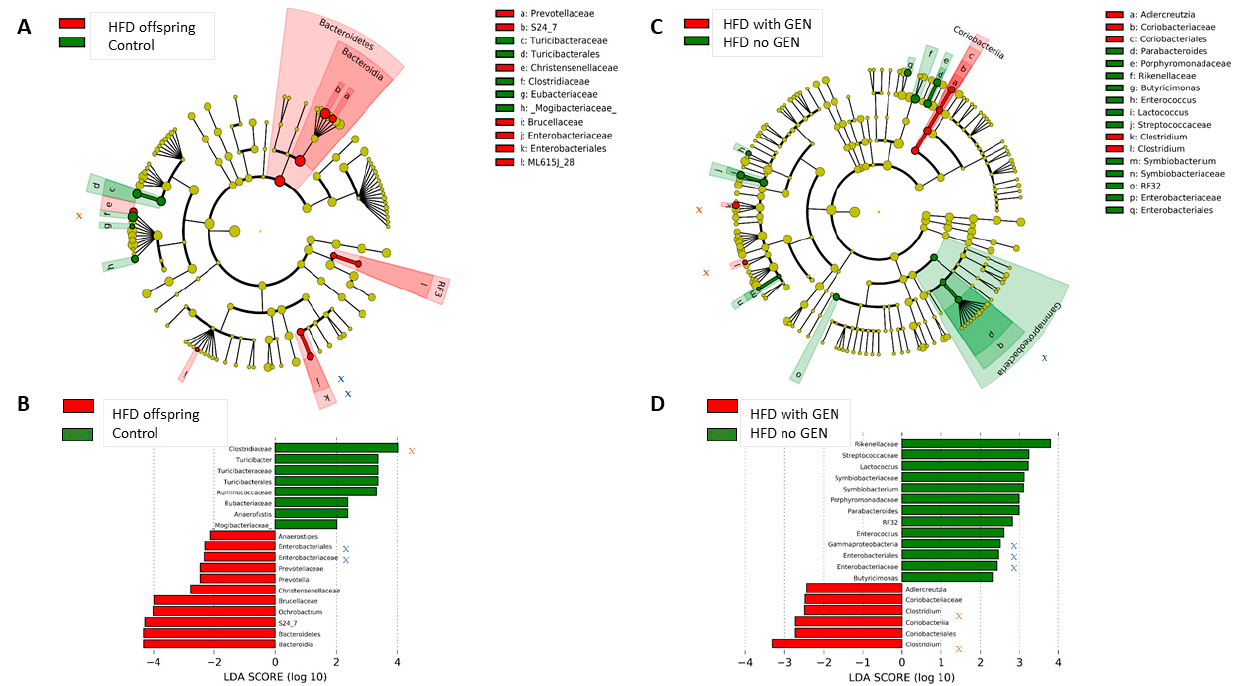
Figure 4. Differences in the gut microbiota in the offspring of control and high-fat diet (HFD) fed dams. Circular cladograms ( A , C ) show results from linear discriminant analysis effect size (LEfSe), presenting the identified OTUs distributed according to phylogenetic characteristics around the circle. Differentially expressed taxa are highlighted by colored and shaded circles. Each circle’s diameter is relative to abundance of taxa in the community. Results between control versus HFD offspring shown in ( A ), and between HFD offspring supplemented with genistein (GEN) or not supplemented shown in ( C ). ( B , D ) LEfSe results showing which bacteria were significantly different in abundance between the control and HFD offspring ( B ), or between HFD offspring supplemented with GEN after tamoxifen versus not supplemented ( D ). Bacteria marked as x or x are those that were significantly different between control and HFD offspring, and reversed by GEN in HFD offspring.